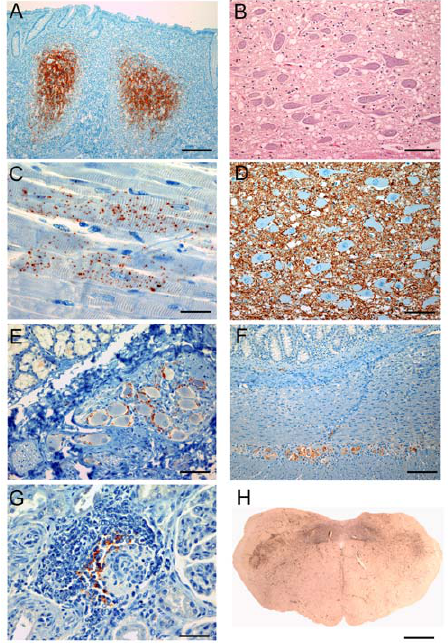
Figure 1. Tissue distribution of PrP CWD and histopathology in clinically affected reindeer orally inoculated with CWD from white-tailed deer. IHC detection of PrP CWD using MAb F99/97.6.1 demonstrates: (A) immunolabeling associated with tingible body macrophages and follicular dendritic cells in a RAMALT biopsy taken at 13.4 mpi, (C) punctate staining in cardiomyocytes, (D) widespread particulate deposits in the dorsal vagal nucleus, (E) immunolabeling within a ganglion adjacent to the submandibular salivary gland, (F) granular PrP CWD in submucosal and myenteric plexuses of the ileum and (G) amongst glomerular lymphocytic infiltrates. (B) Haematoxylin and eosin stained section of the dorsal vagal nucleus reveals vacuolation of the neuropil. (H) PET blot of the obex demonstrating abundant widespread PrP CWD filling the dorsal vagal nucleus and surrounding nuclei. Bars, 150 m m (A); 65 m m (B,D,E); 24 m m (C,G); 92 m m (F); 2.4 mm (H).